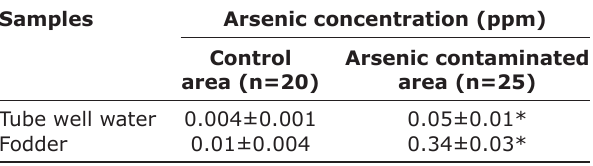
Table-1: Arsenic concentration (mean±SE) in tube well water and fodder samples from control and arsenic contaminated area.